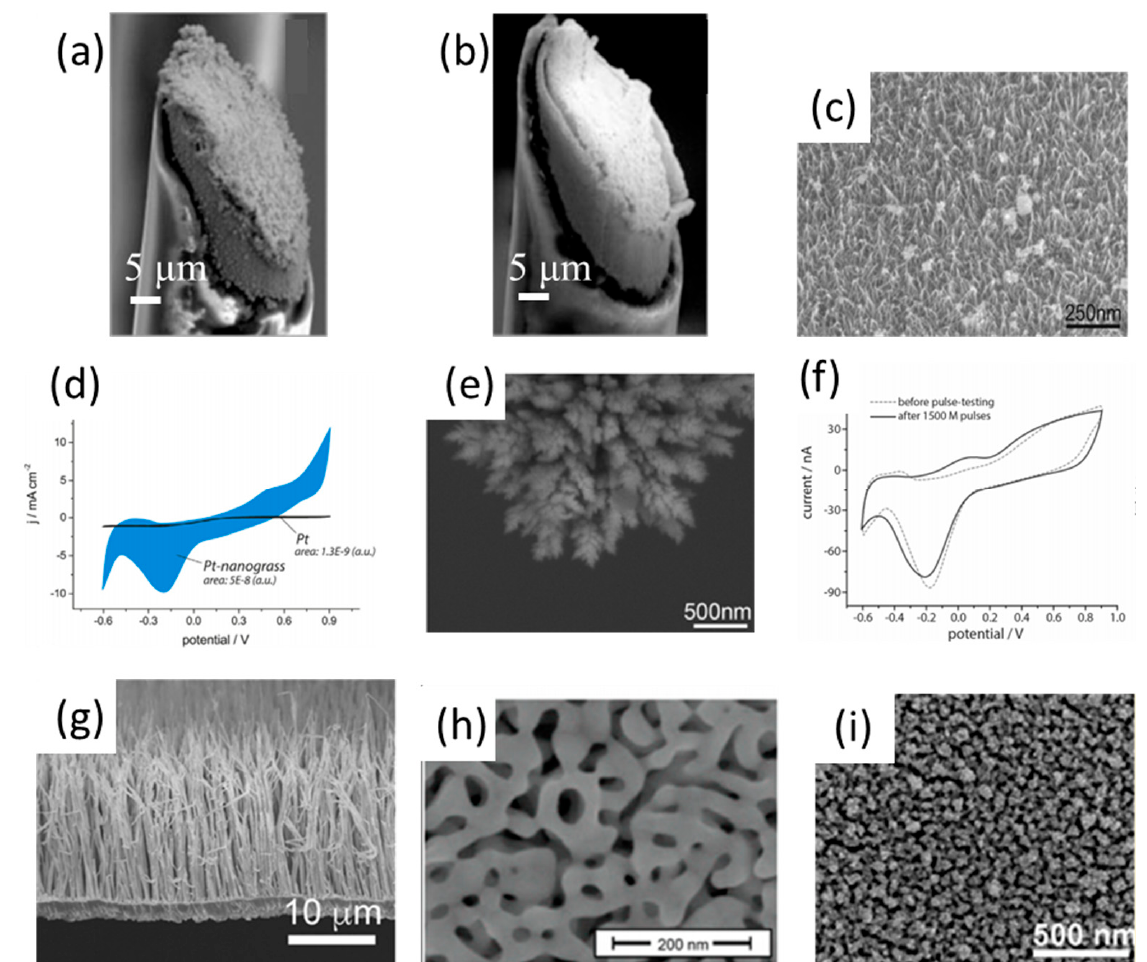
Figure 2. The SEM images of ( a ) the DC-plated platinum black, ( b ) the sonico-plated platinum black, ( c ) Pt-nanograss, ( e ) the NanoPt coating, ( g ) gold nanowires, ( h ) nanoporous gold, and ( i ) Au nanoparticles. ( d ) CV-measurements on 35-mm diameter electrode spots carrying the passive Pt-grass (blue squares) in comparison to sputtered Pt (black triangles). ( f ) The CV-characteristics show only marginal changes in response to the excessive pulsing ( n = 5). ( a , b ) are reproduced with permission from [64], Copyright 2010, Frontiers. ( c , d ) are reproduced with permission from [71], Copyright 2015, Elsevier. ( e , f ) are reproduced with permission from [53], Copyright 2020, ACS Publications. ( g ) is reproduced with permission from [72], Copyright 2008, ACS Publications. ( h ) is reproduced with permission from [73], Copyright 2015, ACS Publications. ( i ) is reproduced with permission from [74], Copyright 2012, ACS Publications.